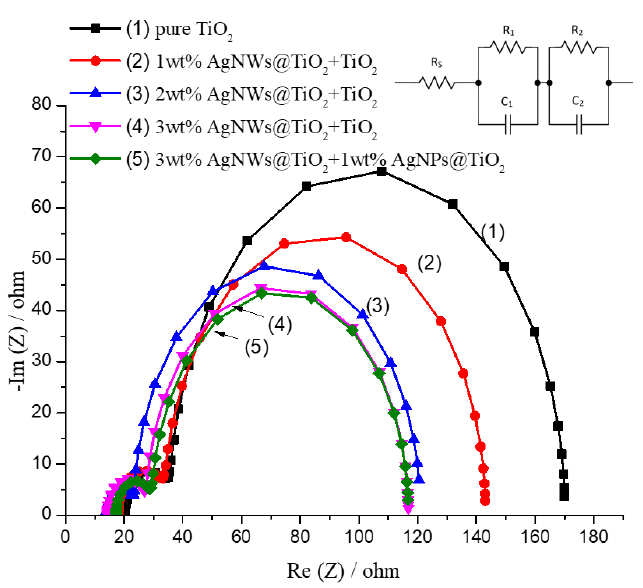
Figure 6. Incident photon-to-electron conversion efficiency (IPCE) curves of the dye-sensitized solar cell (DSSCs) with containing different photoanodes.